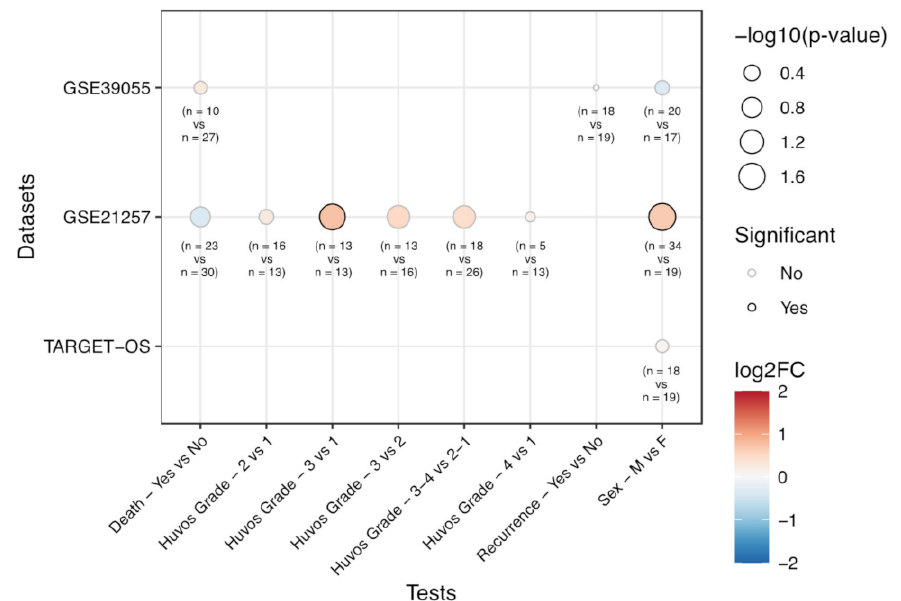
Figure 2. Bioinformatic analysis of EphA2 expression levels from public gene expression datasets on osteosarcoma samples, in relation to patient death status (sample sizes: Yes = 10, 23; No = 27, 30, for GSE39055, GSE21257 datasets, respectively), Huvos grade (sample sizes: G1 = 13, G2 = 16, G3 = 13, G4 = 5; GSE21257 dataset), disease recurrence (sample sizes: Yes = 18, No = 19; GSE39055 dataset), and sex (sample sizes: Male = 20, 34, 23; Female = 17, 19, 30, for GSE39055, GSE21257 and TARGET-OS dataset, respectively). The size of the dots is proportional to the significance of the statistical tests, while the color scale represents the log 2 Fold Change (FC) of expression between the compared groups. Dots with a black border represent tests associated with a p -value lower than